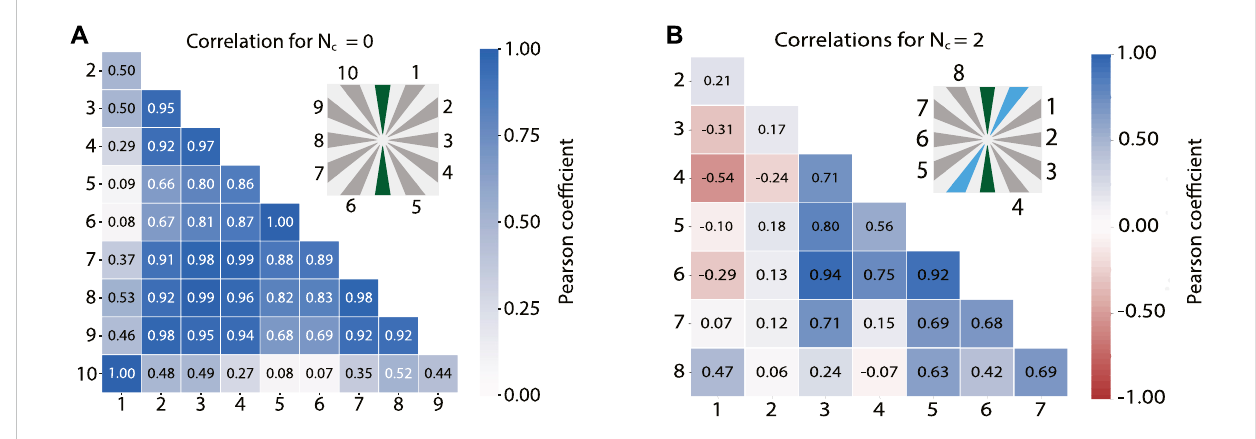
FIGURE 3 Correlation matrices. (A) Correlation matrix of the output currents of the DNPU for the fi xed ELM mode (N C = 0) for VC dimension 7. The darker the blue, the higher the correlation in the output currents. (B) Correlation plot for label 5 ([0000101]) of the outputs of the DNPU in the N C = 2 tuneable ELM